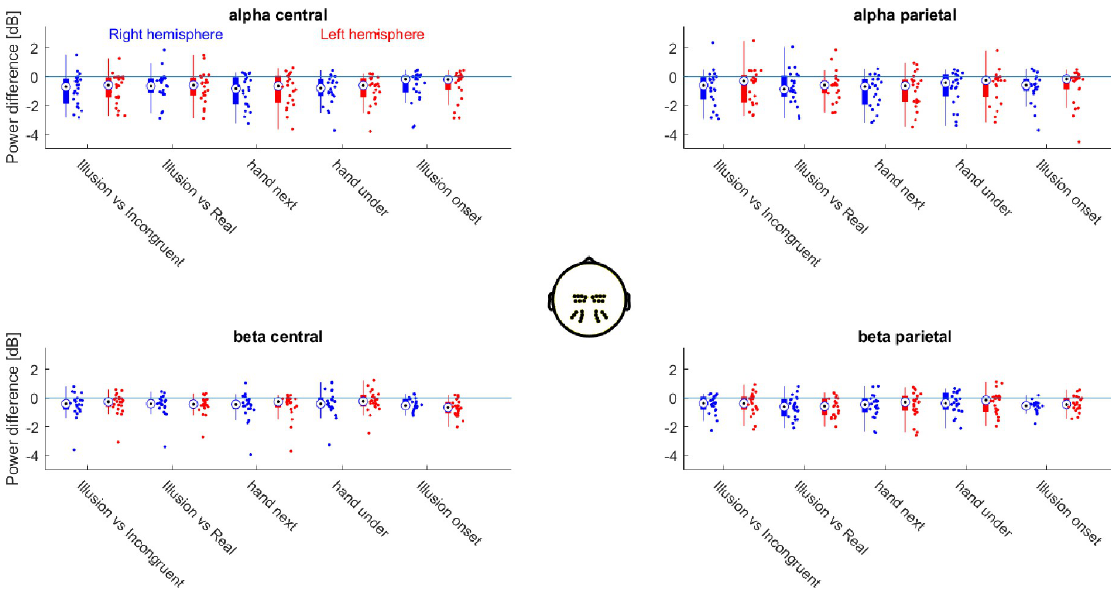
Fig 3. Hemisphere-specific differences in alpha and beta power over central and parietal regions of interest. Central panel shows the 4 ROIs, defined respectively by left and right central and parietal electrodes. Boxplots show the participant-wise power differences for the individual contrasts indicated, ROI and frequency band. Dots indicate individual participants. ‘hand next’ and ‘hand under’ refer to the comparison of Illusion and Incongruent for each hand arrangement separately. Ill: Illusion condition, Inc: Incongruent condition.